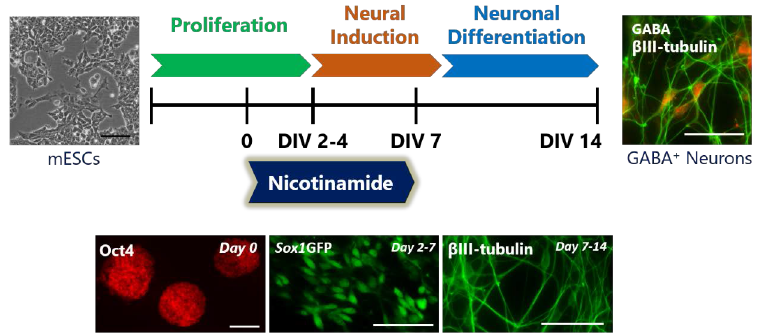
Fig 1. Schematic diagram of time-course analysis of neural and neuronal differentiation in the presenceof nicotinamide. Undifferentiated cells were culturedas monolayers in N2B27medium for different durationsto investigatewhethernicotinamide wouldinfluencethe conversionof Oct4 + undifferentiated stem cells (scale bar = 100 μ m) to Sox1 GFP neuralprogenitors (scale bar = 50 μ m) and thus drive differentiationtoward β III-tubulin + neurons(scale bar = 50 μ m). The potentialof nicotinamide was assessedusing immunocytochemistry at different culture periods from days 2–14.